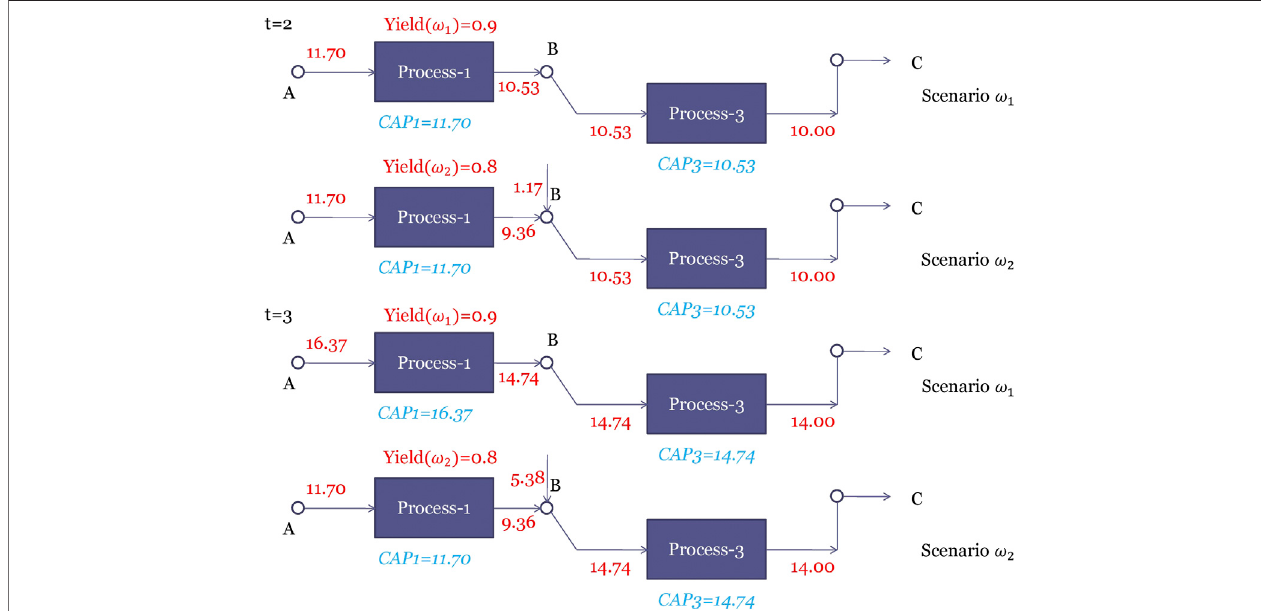
FIGURE 11 | Optimal solution of the three-stage process network problem under endogenous